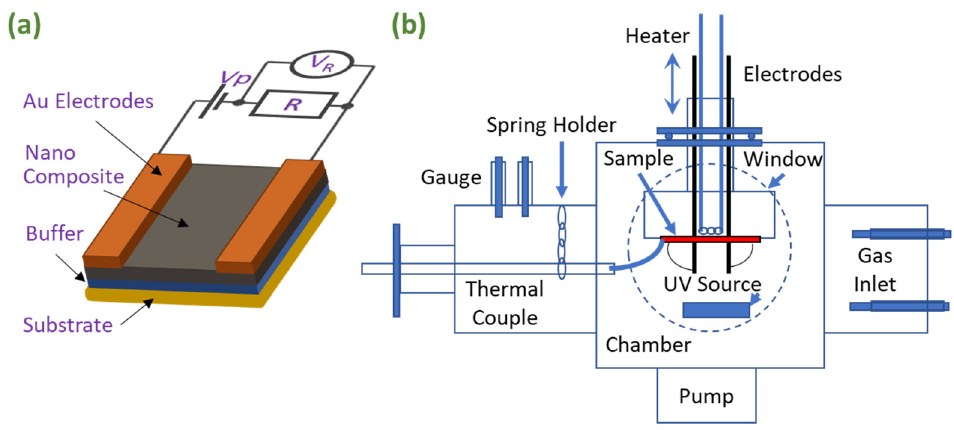
Figure 3. Schematics of the ( a ) structure of prototypes and ( b ) homemade characterization